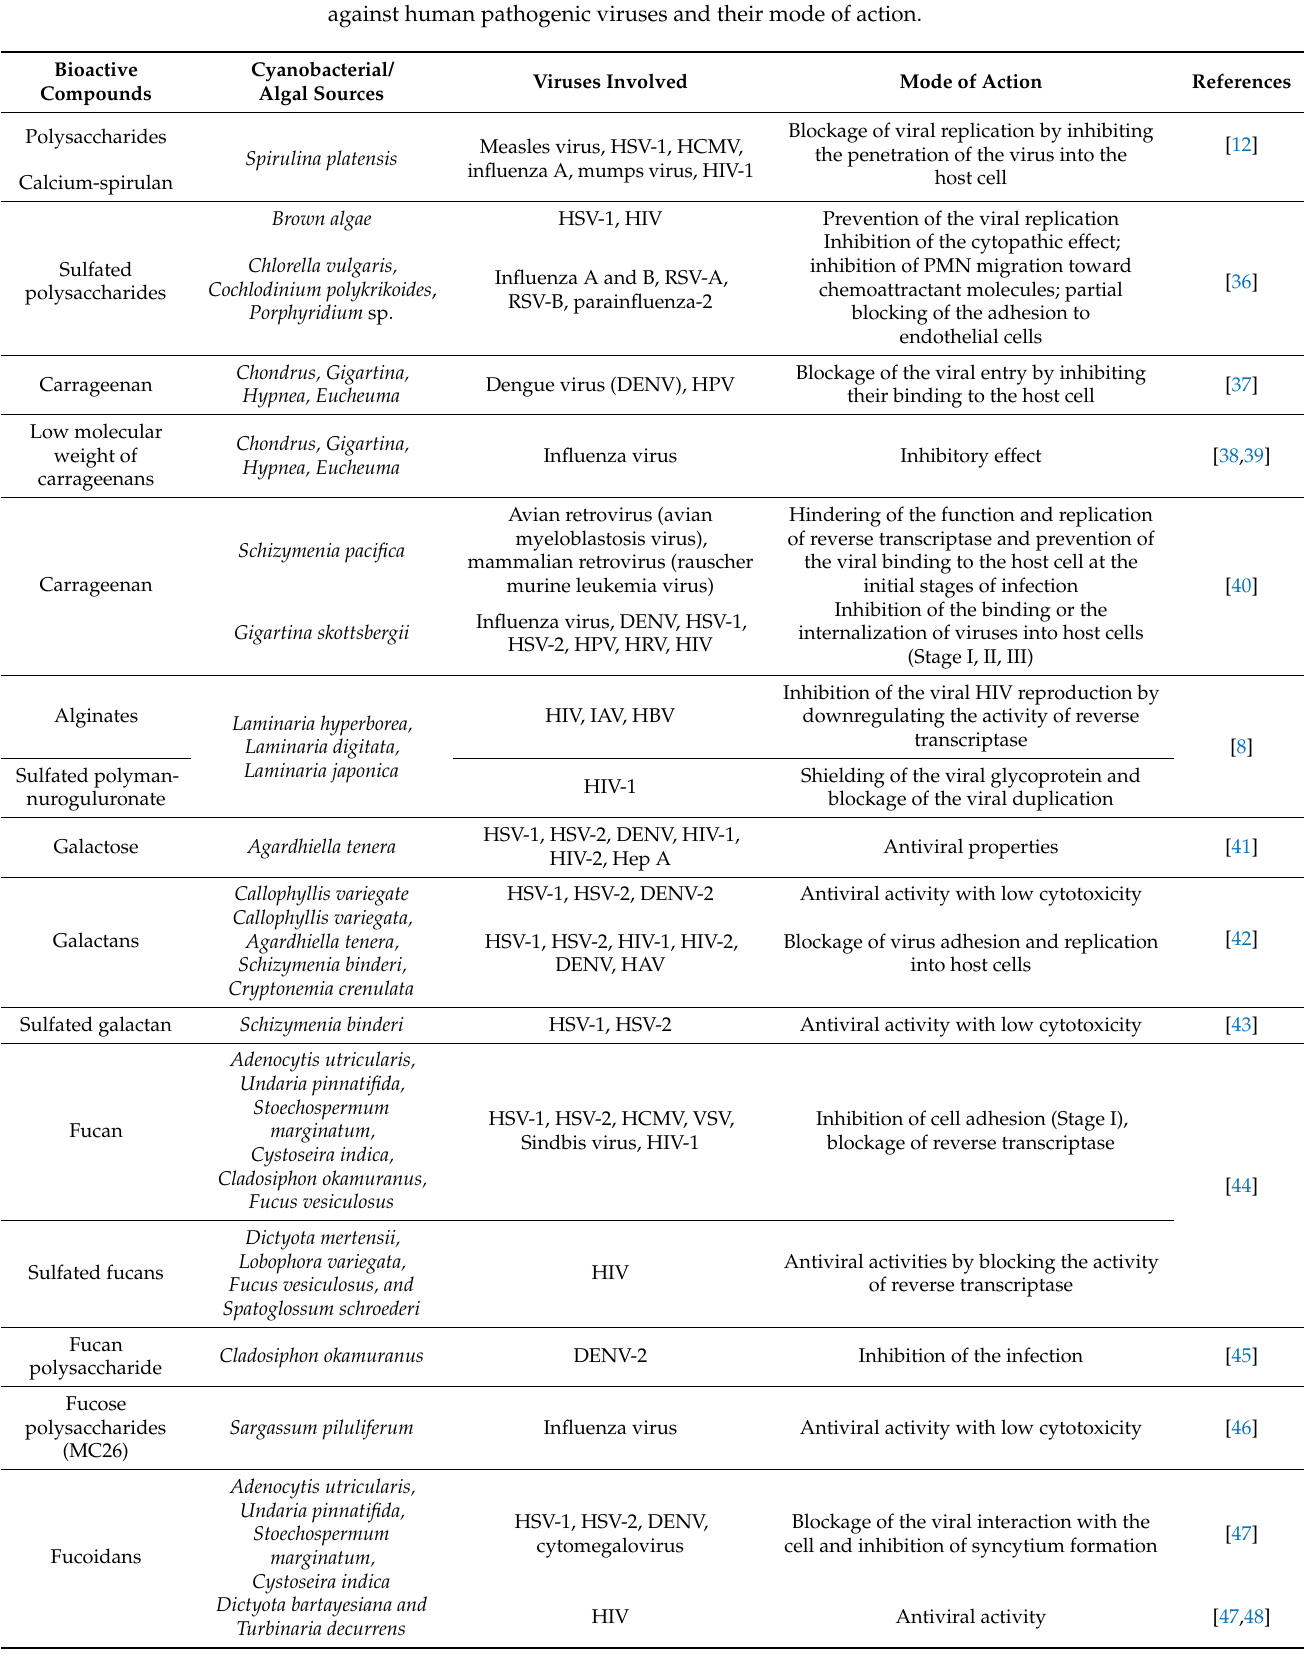
Table 1. Cyanobacterial and algal-derived bioactive metabolites and their potential antiviral activities against human pathogenic viruses and their mode of